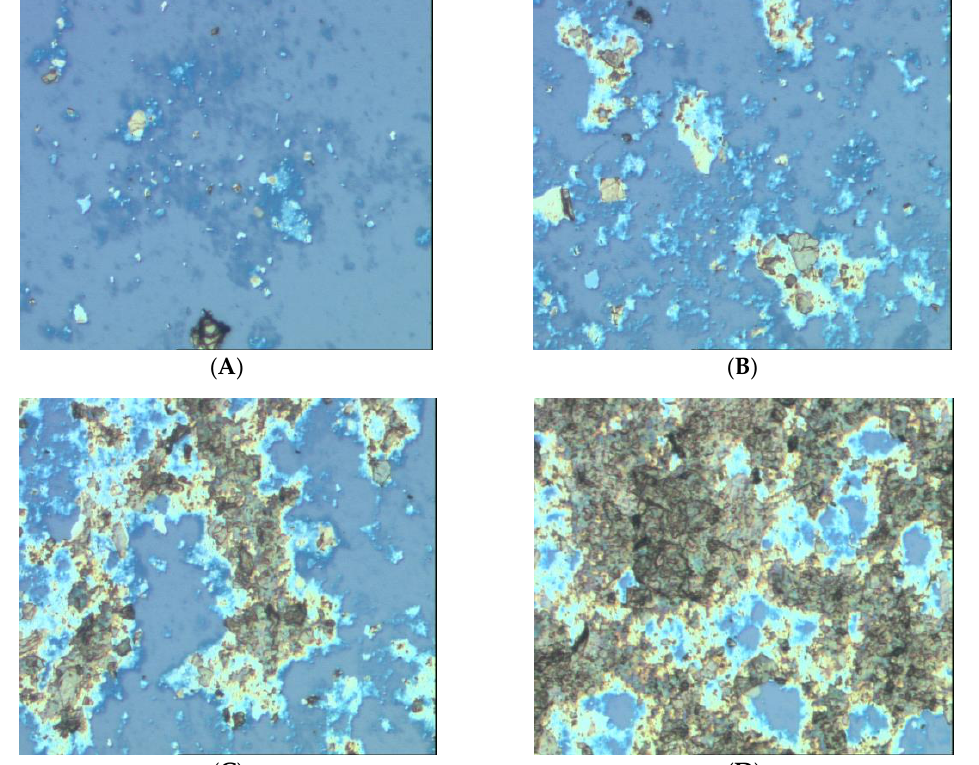
Figure 4. The Leica optical microscope DM4000M with Sarfusoft 2.1 system images showing the increase of surface coverage with the number of adsorbed deposition cycles (GO + /GO − ) n ; ( A ) 1 deposition cycle, ( B ) 3, ( C ) 5, ( D ) 7 deposition cycles, respectively. Size of the image 100 µm × 100 µm.